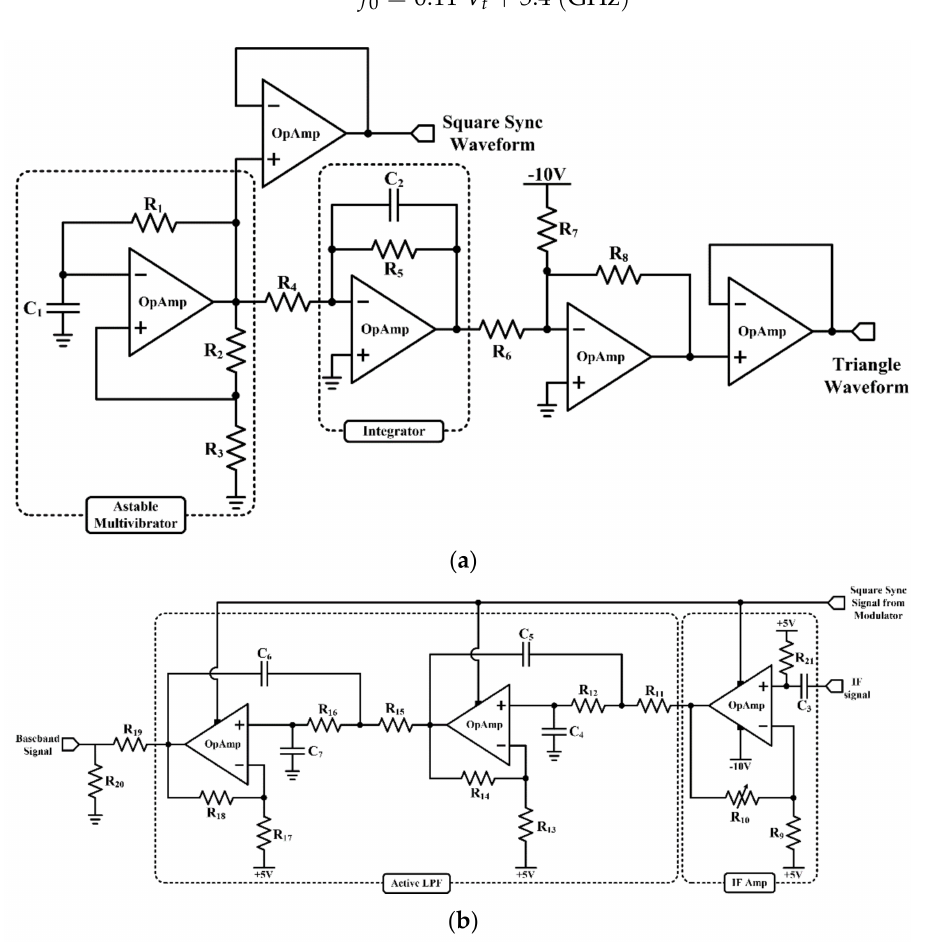
Figure 2. ( a ) Designed frequency modulator (FM) and ( b ) baseband circuits.